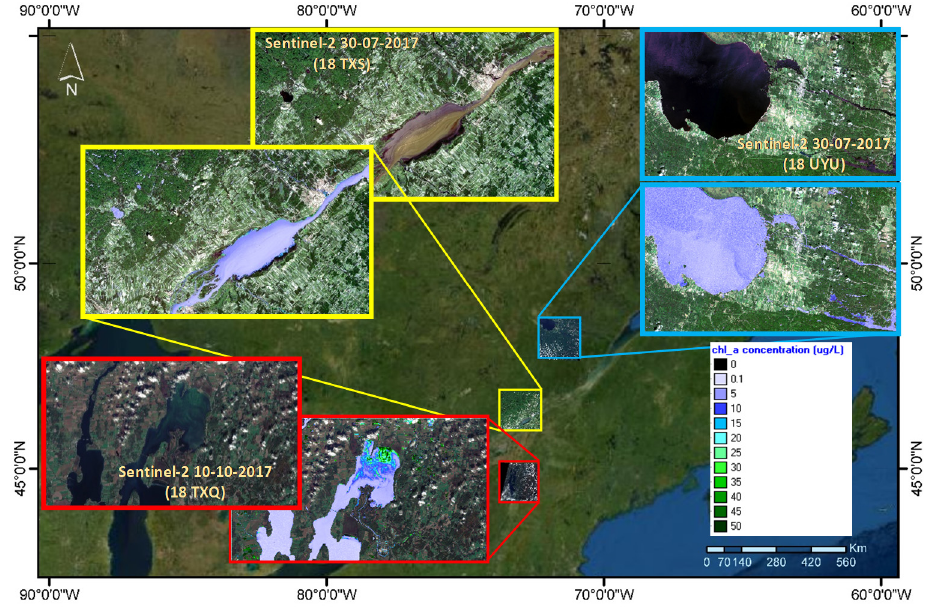
Figure 18. Spatial distribution of chl_a concentration derived from Sentinel-2 on three different tiles. The yellow frame is a zoomed part of the 18 TXS tile on Lake Saint-Pierre, the red frame is a zoomed part of the 18 TXQ tile on Missisquoi Bay of Lake Champlain, and the blue frame is a zoomed part of the 18 UYU tile on Lake Saint-Jean.